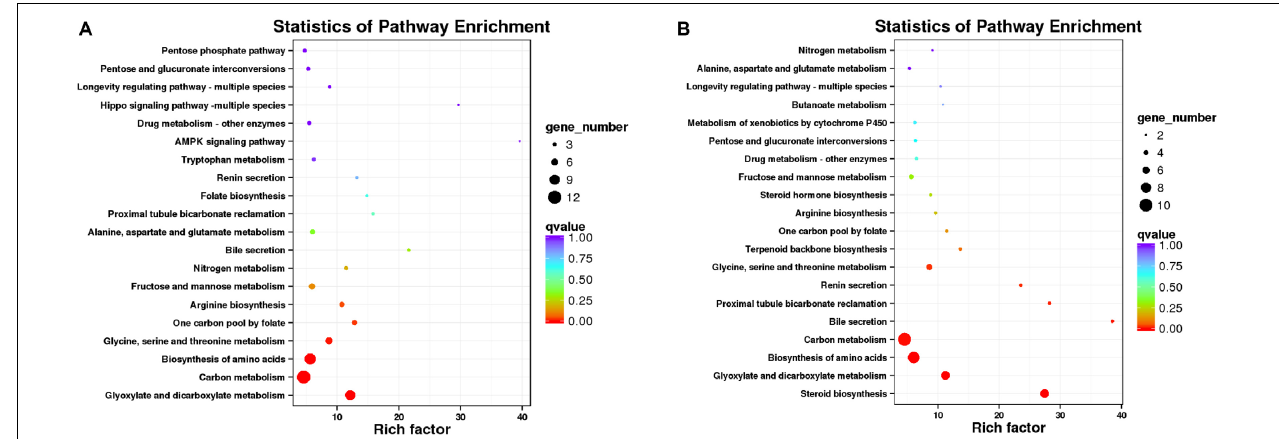
FIGURE 8 | Scatterplot of enriched KEGG pathways for DEGs ( A , 48 h; B , 96 h). Sizes of bubbles indicates the number of DEGs in the corresponding pathway, and the colors of the bubble represent the q -value, q -value is the P -value after multiple hypothesis